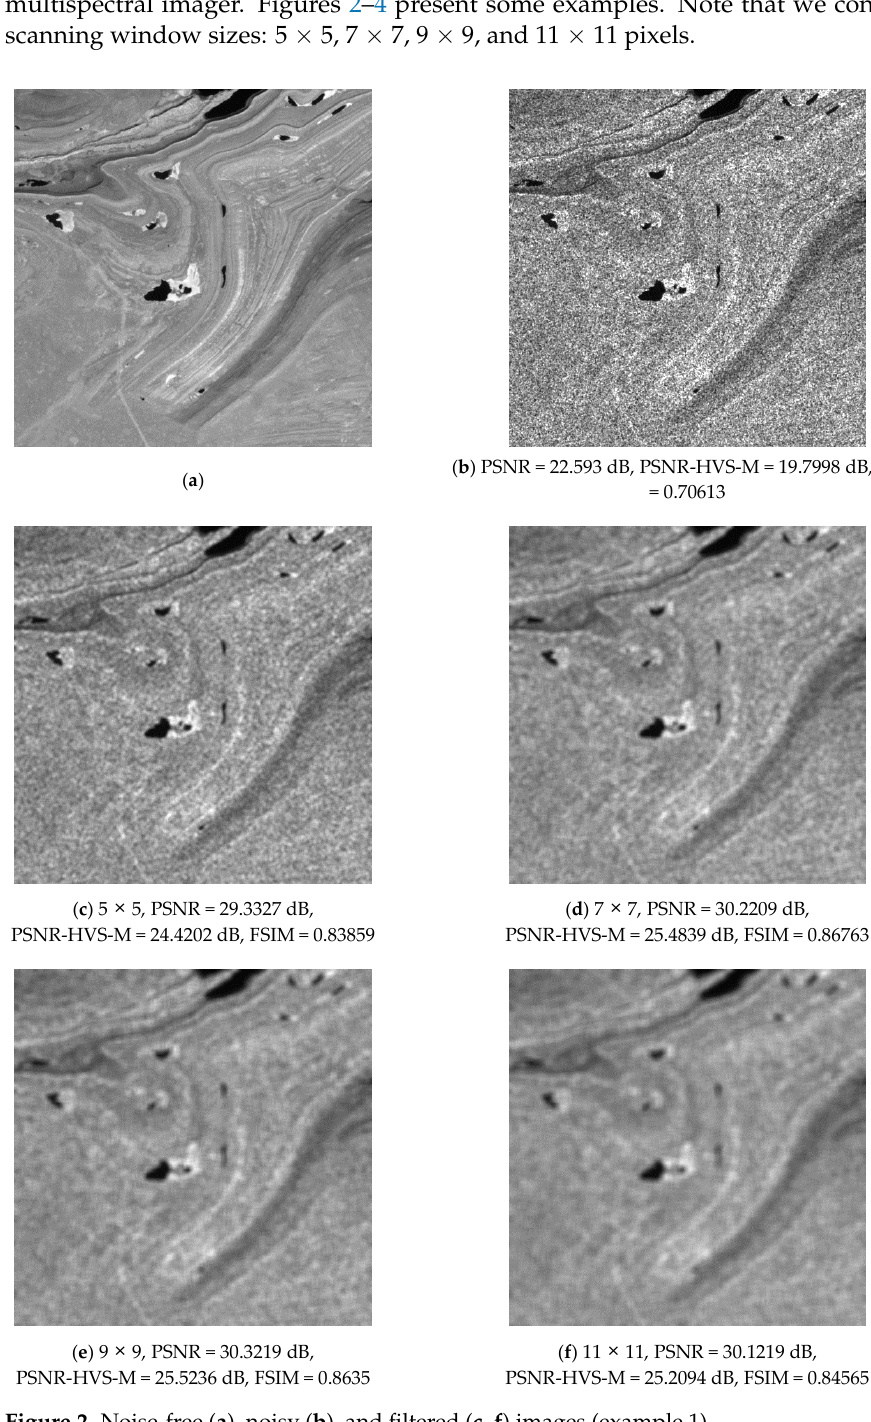
Figure 2. Noise-free ( a ), noisy ( b ), and filtered ( c – f ) images (example 1).